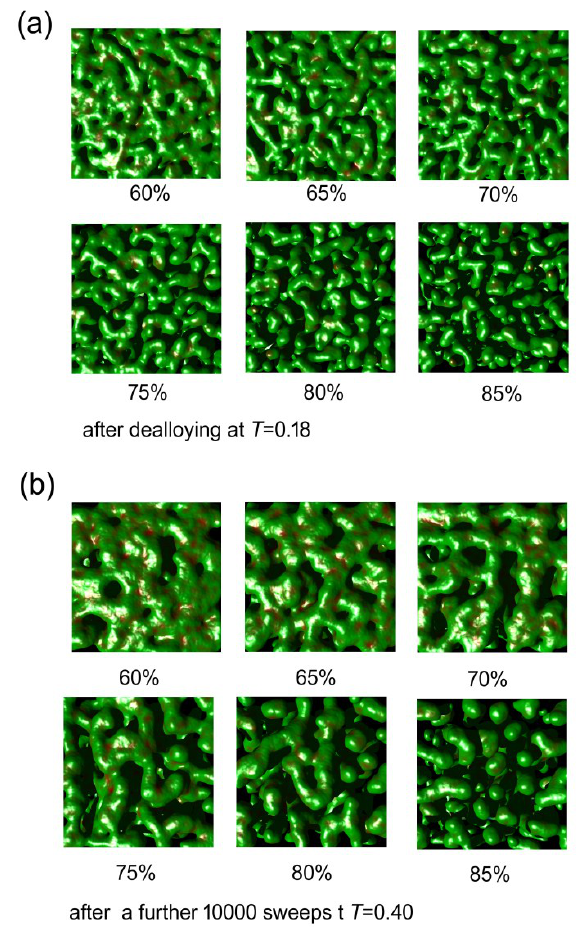
Figure 8. Effect of 10,000 Monte Carlo annealing sweeps at T = 0.4 on the morphology of model de-alloyed sponges prepared using series of precursors containing from 60 to 85 at.% Al (top